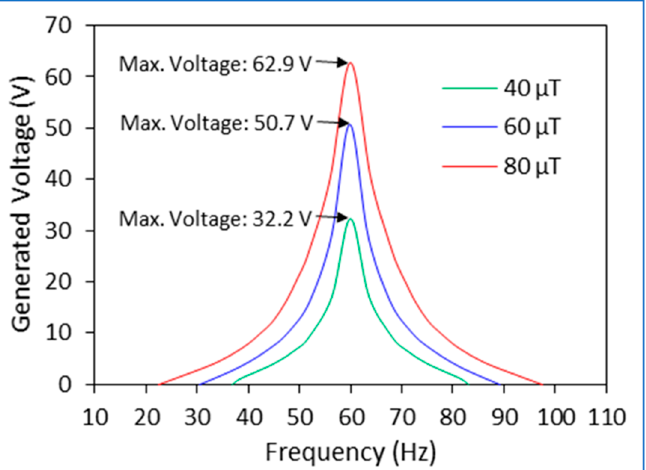
Figure 3. Finite element results of the maximum voltages according to the variations of magnetic field and frequency.